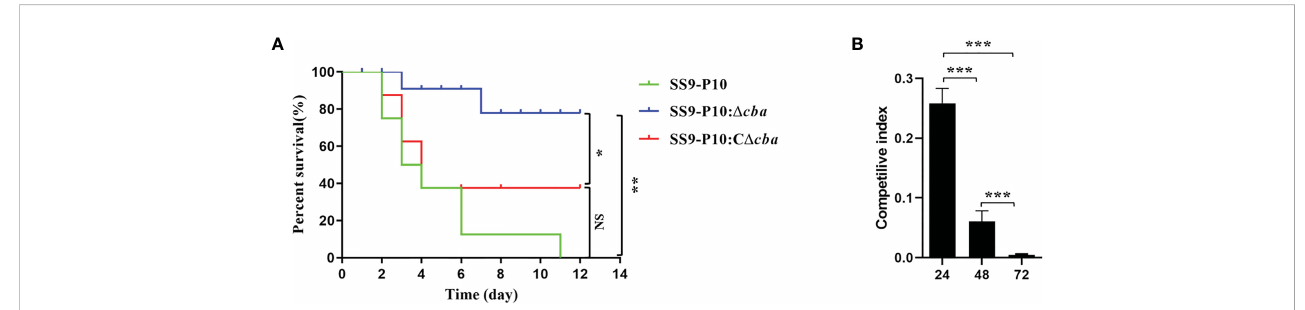
FIGURE 4 Virulence assessment in vivo . (A) Comparison of survival rates using the Log-rank (Mantel-Cox) test.Using a mouse model of infection, approximately 10 6 colony forming units (CFUs) of SS9-P10, SS9-P10: D cba or SS9-P10:C D cba in 100 µL of sterile phosphate-buffered saline (PBS) was used to challenge a group of mice via an intraperitoneal injection. Survival was observed daily for 12 days. The cba -expressing strains were more virulent than their cba - de fi cient counterparts (SS9-P10 vs. SS9-10 D cba and SS9-P10:C D cba , n=8, *P < 0.05; **P <0.01; NS p>0.05 ). (B) Competilive index analysis between the SS9-P10: D cba and SS9-P10 in ICR mice. Data were analyzed with the Kruska-Wallis multiple comparison test (n = 8) and presented with mean ± SD ( ***P<0.001